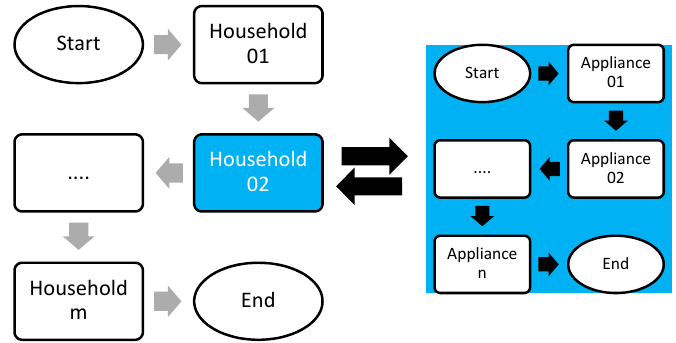
Figure 1. The bottom-up load modeling diagram.